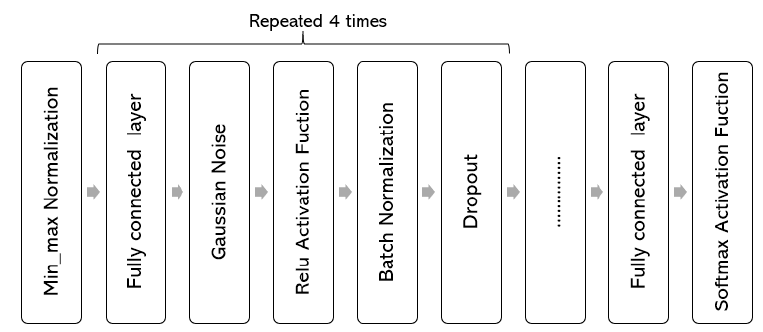
Figure 6. Block diagram of the DNN